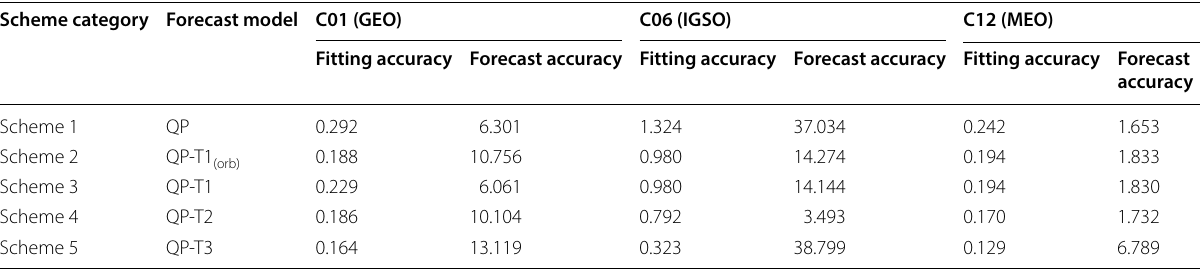
1,2,3) represents the periodic term =